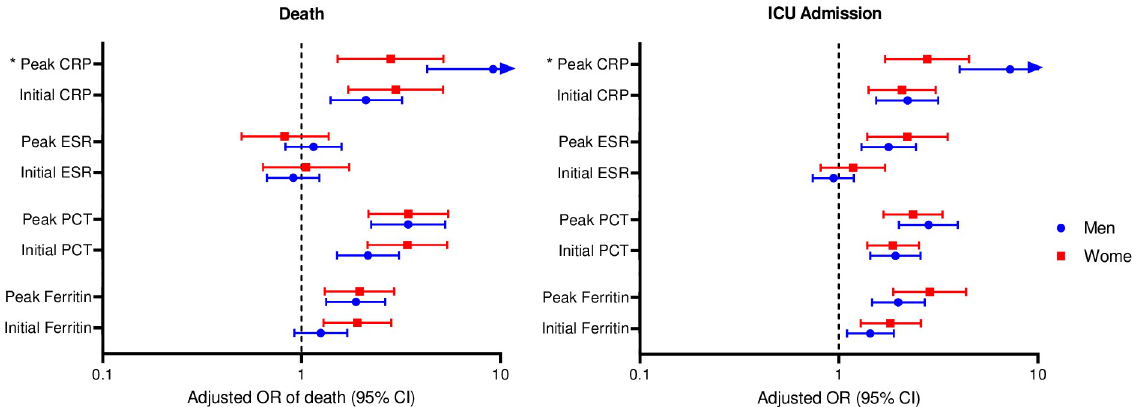
Fig 1. The association of inflammatory markers with death and ICU admission in men and women with COVID-19 infection. � = sex � inflammatory marker p interaction <